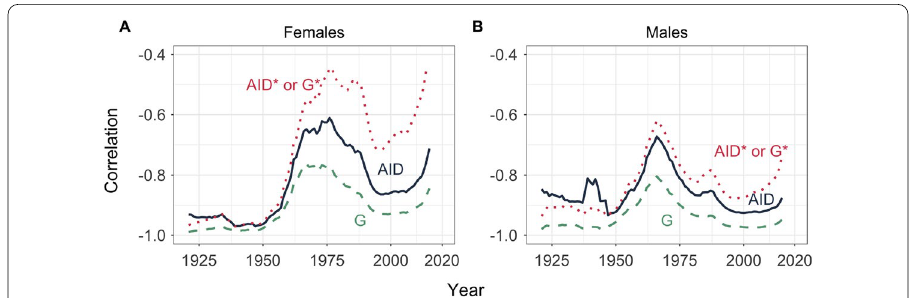
Fig. 5 Pearson correlation between life expectancy and lifespan inequality measures (absolute, relative and normalized Gini indices) over different periods. A Results for females; B results for males. Calculations are based on HMD country-year observations from year T HMD